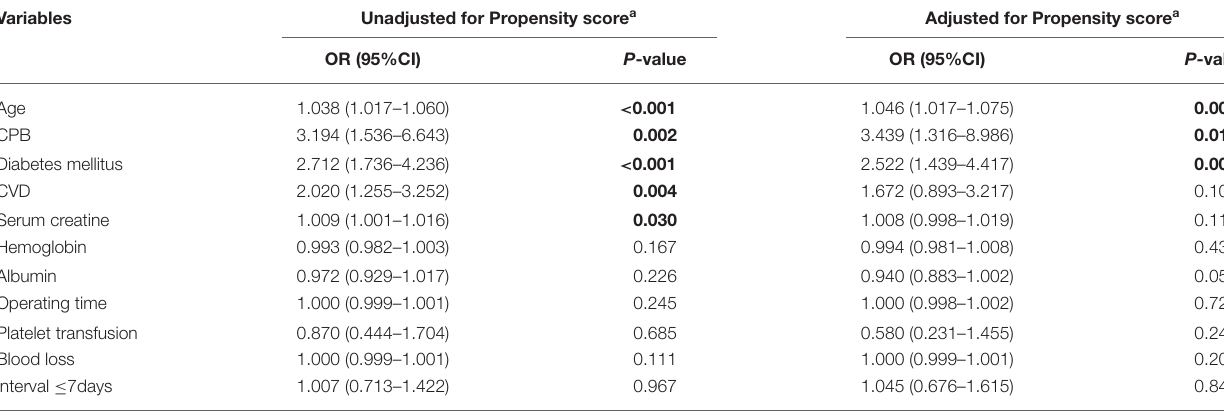
TABLE 3 | Multivariable logistic analysis for acute kidney injury in the study patients.